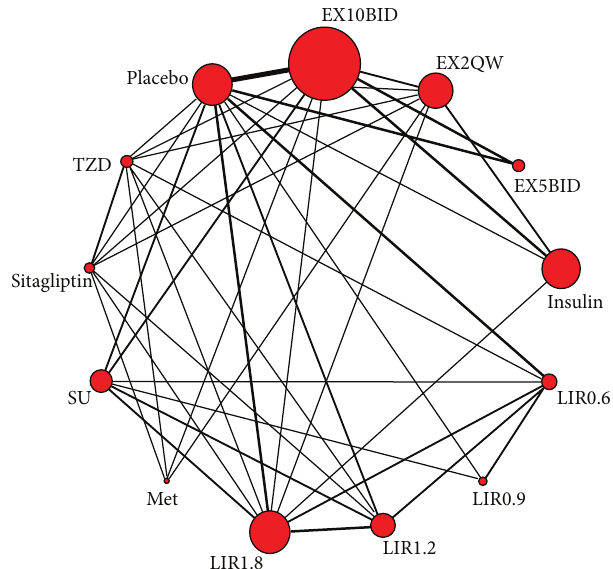
Figure 2: Network of clinical trials about GLP-1 RAs and other hypoglycemic drugs or placebo in patients with Type 2 diabetes. Lines connect the interventions that have been studied in head-to-head (direct) comparisons in the eligible RCTs. The width of the lines represents the cumulative number of RCTs for each pairwise comparison and the size of every node is proportional to the number of randomized participants (sample size). EX5BID: exenatide 5 𝜇 g twice daily; EX10BID: exenatide 10 𝜇 g twice daily; EX2QW: exenatide 2 mg once weekly; LIR0.6: liraglutide 0.6 mg once daily; LIR0.9: liraglutide 0.9 mg once daily; LIR1.2: liraglutide 1.2mg once daily; LIR1.8: liraglutide 1.8 mg